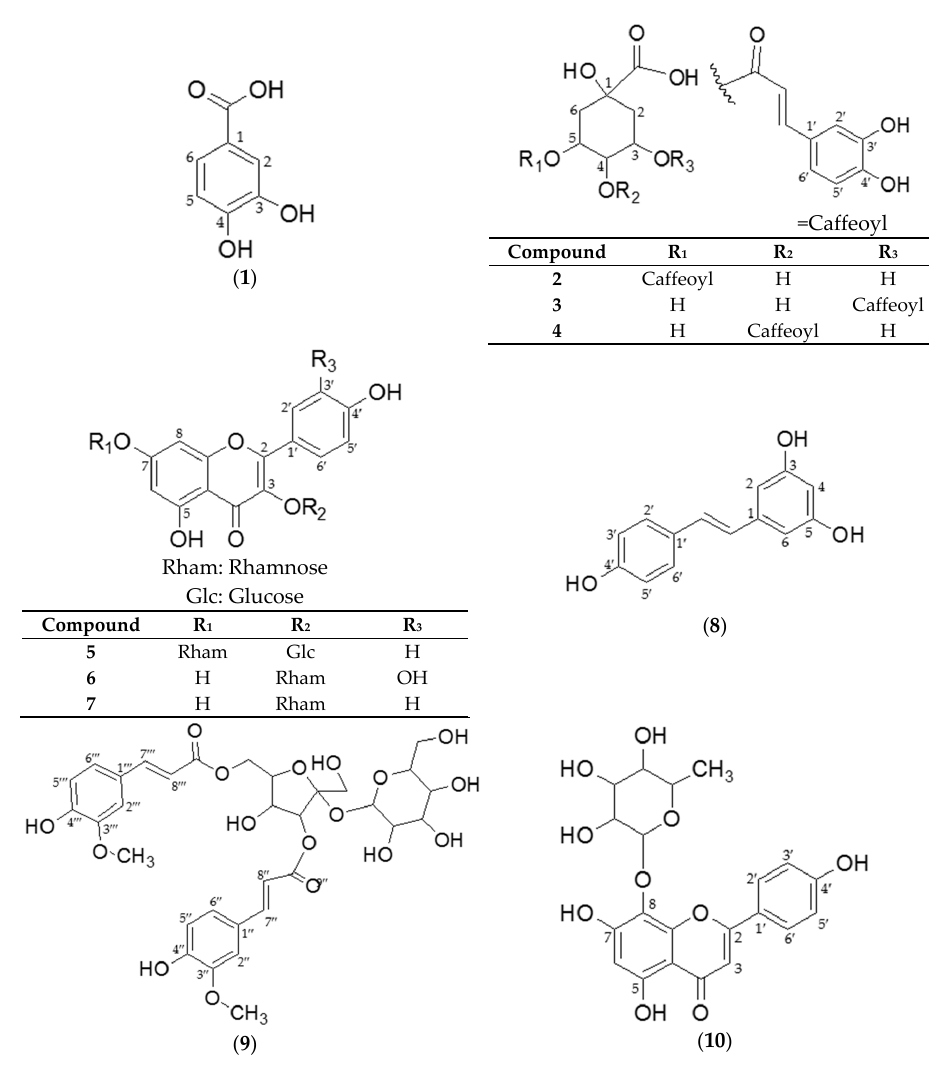
Figure 3. Chemical structures of compounds 1 – 10 isolated from Smilax china L. stem.